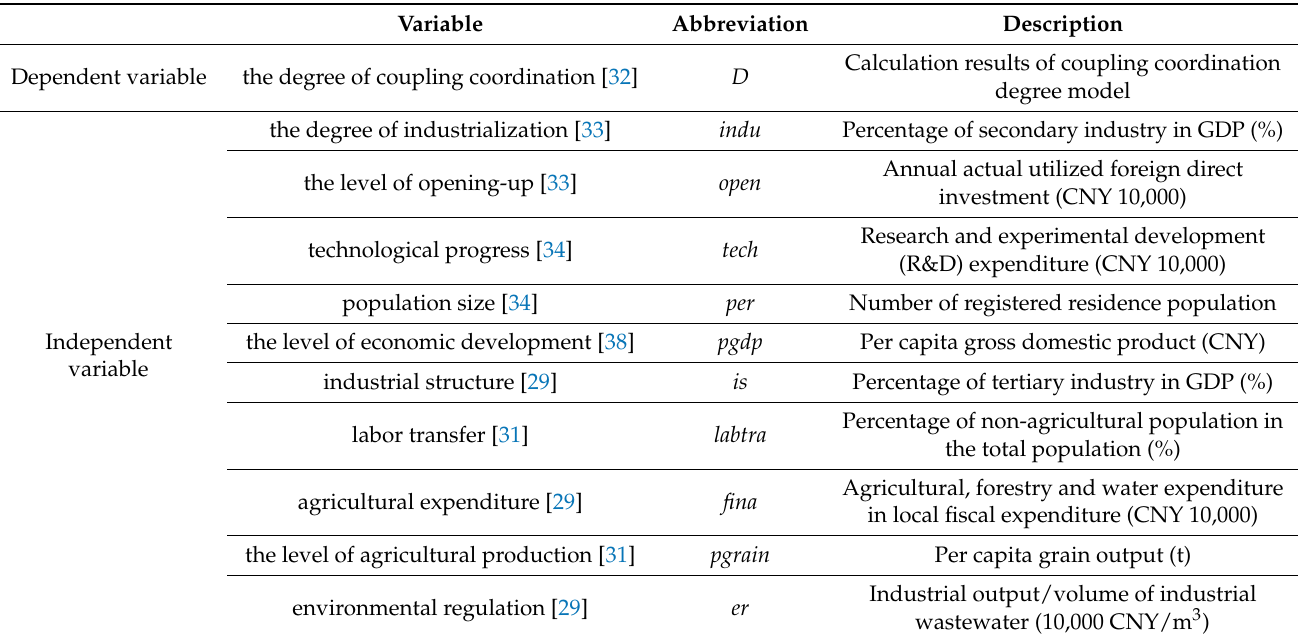
Table 3. The driving factors of coupling coordination